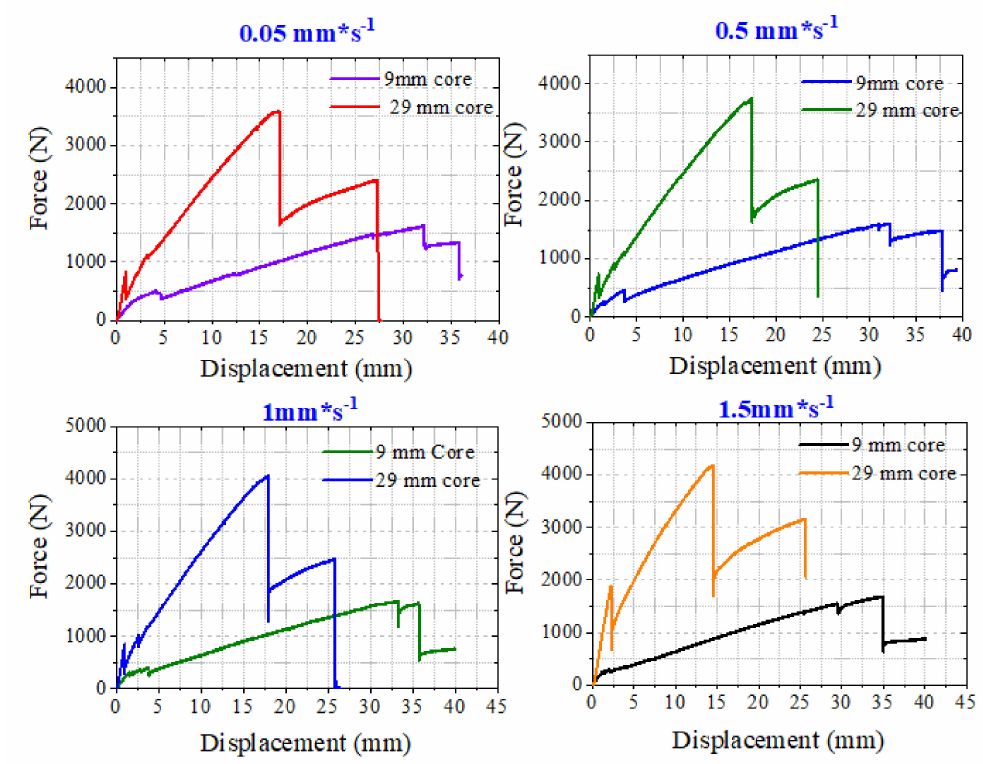
Figure 7. Comparative analysis of behavior of a CFRP facesheet / foam sandwich beam under three-point loading that had a span length of 9 inches at di ff erent displacement